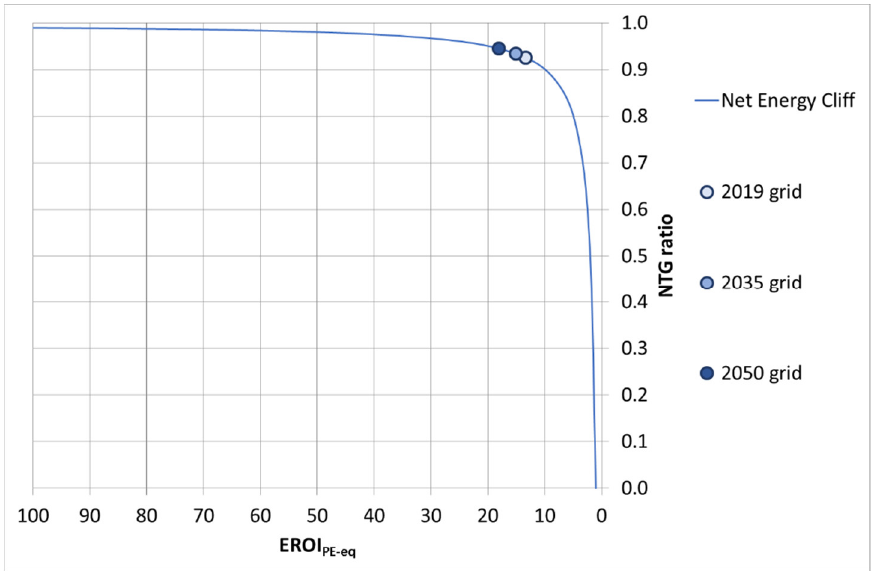
Figure 14. Evolution of the Net-to-Gross (NTG) primary energy return ratio of the UK grid mix (results include the effects of energy storage and transmission).